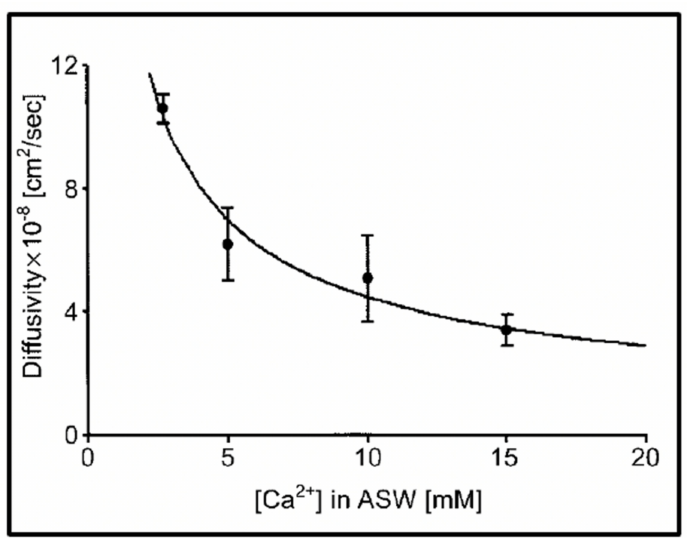
Figure 8. Experiments conducted in Phaeocystis equilibrated in artificial seawater (ASW) containing increasing concentrations of Ca result in a characteristic power-law decrease of the diffusion of the exocytose Phaeocystis gel. Point corresponds to the mean ± SEM of seven measurements. As shown in Figure 9, the hydrated polymer matrix of exocytosed Phaeocystis gels when exposed to conditions that mimic the intragranular environment, i.e., low pH and high [Ca 2+ ] can recondense undergoing a characteristic polymer gel volume transition [22].